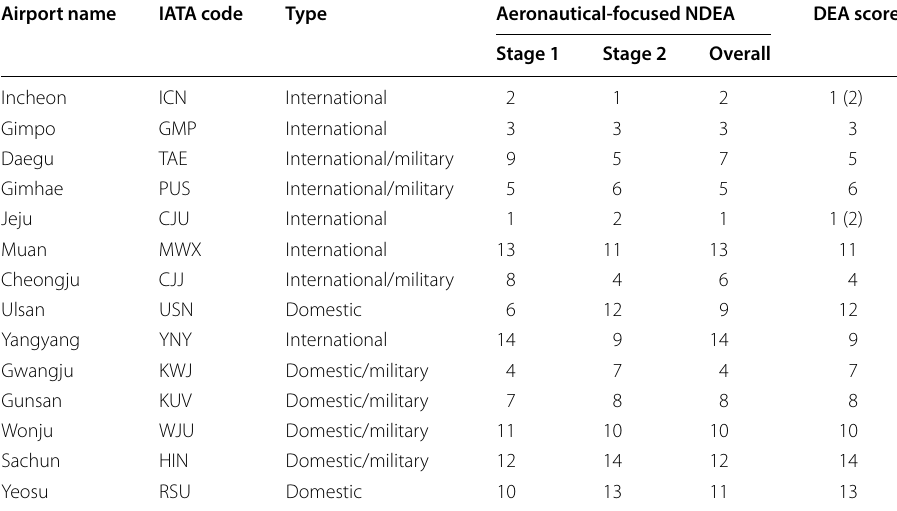
Table 2 Airport ranking based on average airport aeronautical efficiency scores 2011–